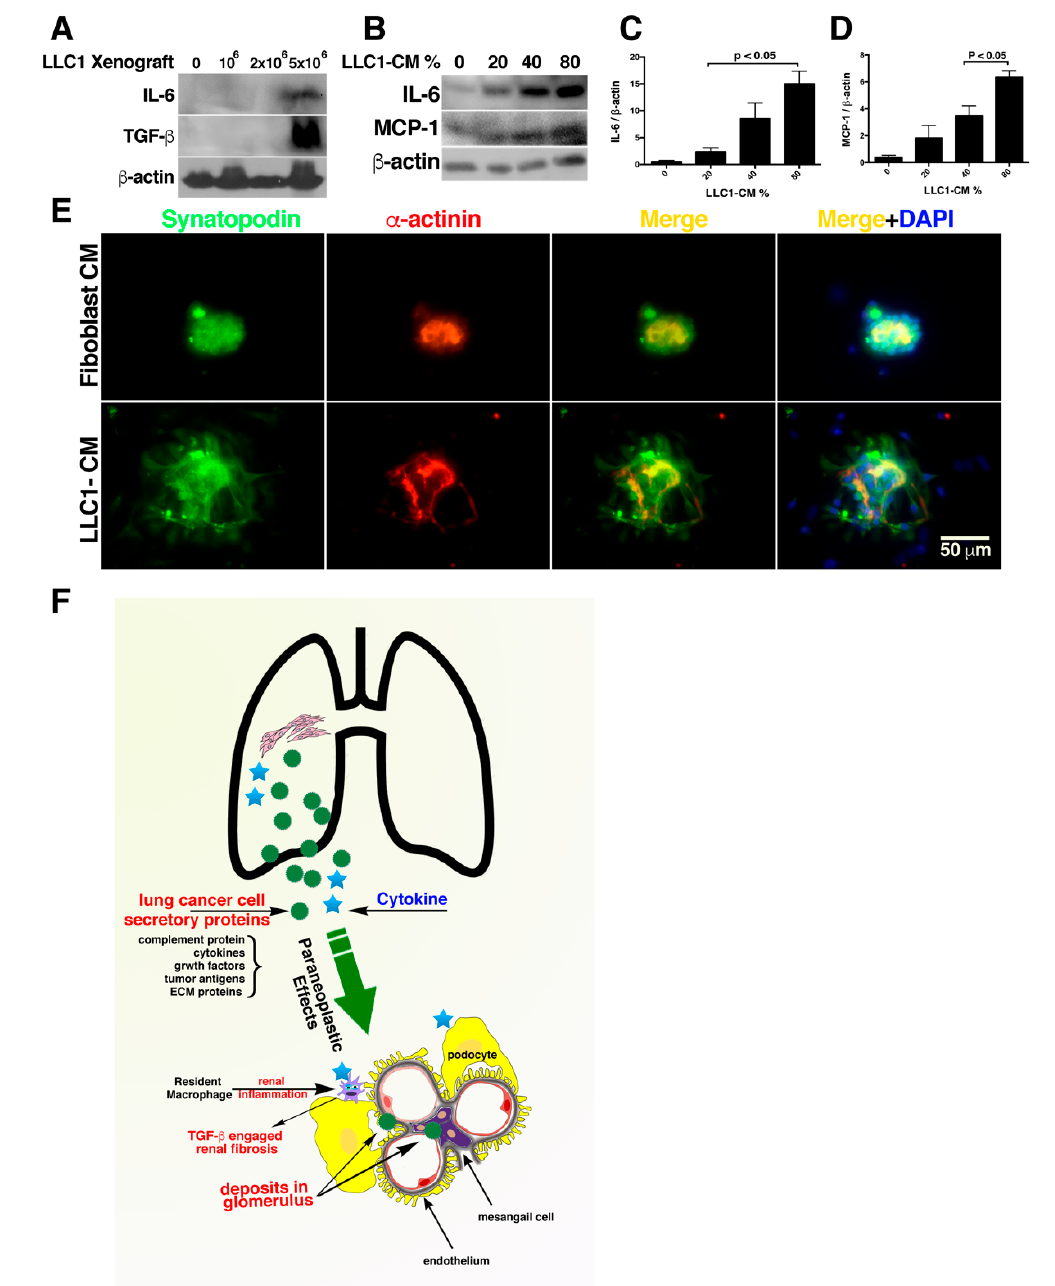
Figure 7. LLC1 cell-conditioned medium (LLC1-CM) provoked inflammation in renal cells and elicited glomerular integrity. ( A ) Western blot analysis showed elevated IL-6 and TGF- β expressions in the kidneys of the lung cancer mice. The whole gel figures are shown in Figure S5. ( B ) The LLC1-CM provoked inflammation in the kidneys. As 20%, 40%, and 80% conditioned medium was added to NRK-52E cell cultures, the IL-6 and MCP-1 expressions increased. ( C ) IL-6 expression level in NRK-52E cells was calculated as the ratio of IL-6 to β -actin. IL-6 levels were relatively higher when the cells were exposed to conditioned medium collected from LLC1 cell culture. ( D ) When NRK-52E cells were exposed to LLC1 cell-derived conditioned medium, the MCP-1 expression was obviously increased. ( E ) Exposure of glomeruli to LLC1-conditioned medium (LLC1-CM) leads to loss of glomerular integrity and the podocytes in the glomerulus do not arrange in cluster-form. In contrast, when glomerulus cultured in fibroblast-conditioned medium (fibroblast CM), podocytes tightly cluster (bar = 50 µ m). ( F ) Schematic representation depicted a plausible pathogenic mechanism associated with glomerulopathy in the lung cancer